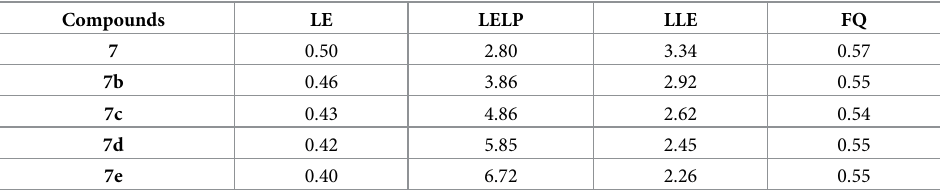
Table 5. Ligand metric analyses of the selected protocatechuates 7, 7b-7e.